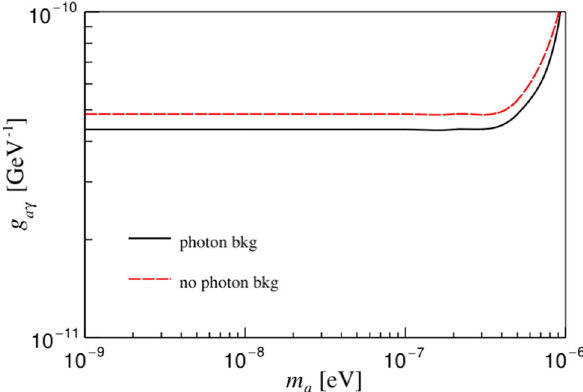
Fig. 14 Impact on the constraint from the Fiducial case in the presence of a photon background. The case with no photon background in red dashed curve, while in the presence of a photon background we obtain the black curve